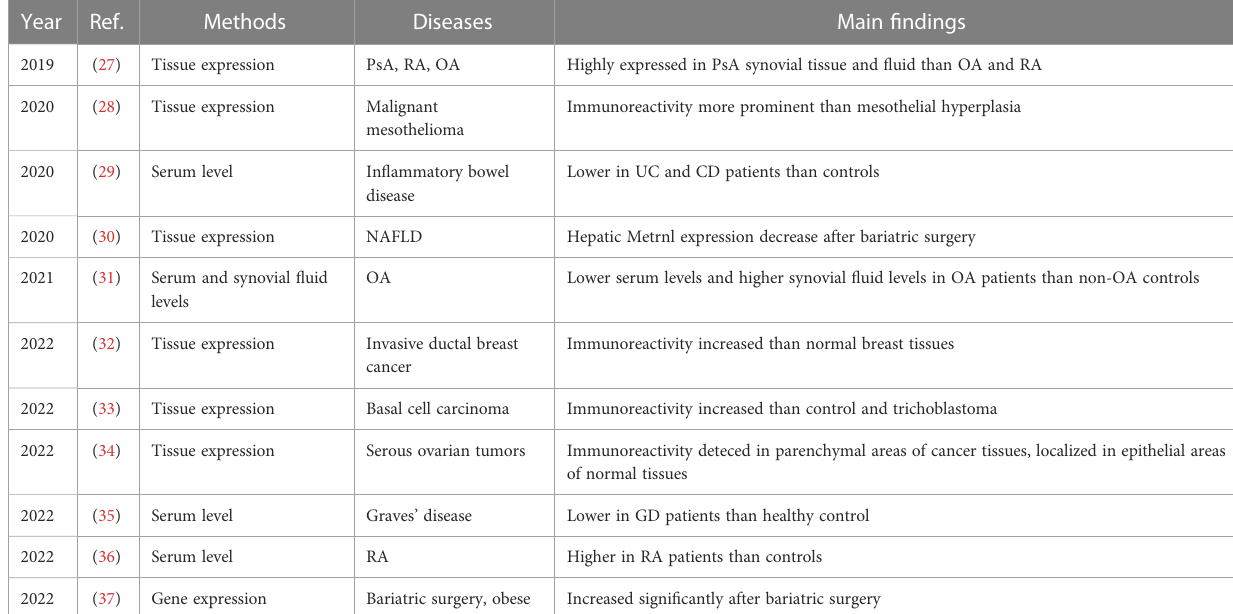
TABLE 2 Metrnl-related circulation levels and tissue expressions of human clinical studies on in fl ammation and immunology. Year Ref.